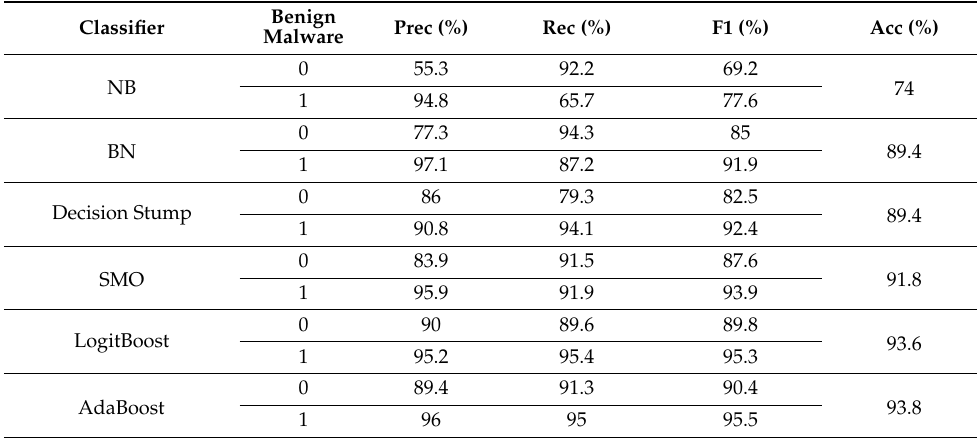
Table 8. Summary of machine learning classifiers’